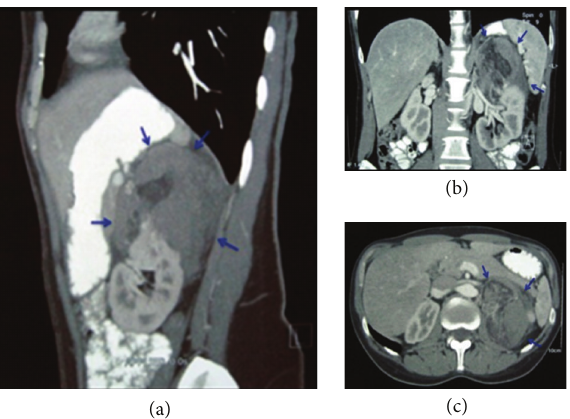
Figure 1: CT imaging of the abdomen depicting AML of the left kidney. (a) Sagittal plane. (b) Coronal plane. (c) Transverse